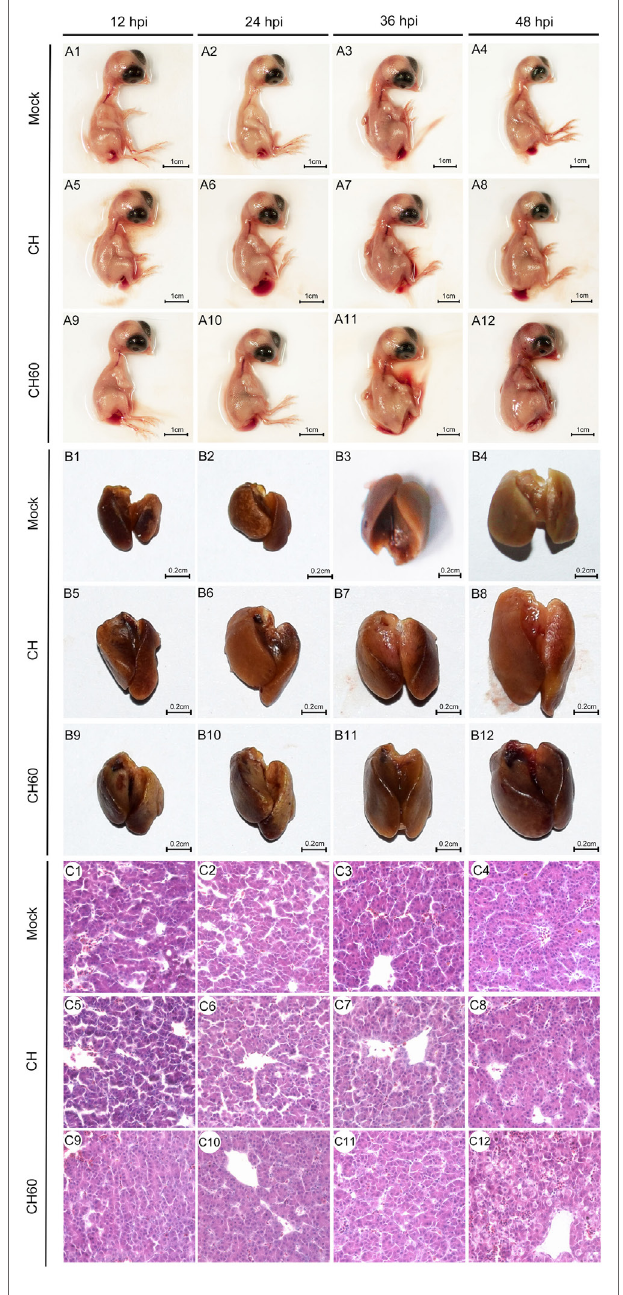
FigUre 1 | Gross lesions and histopathological lesions in CH- or CH60- infected livers of embryonated eggs. Embryonated eggs were infected with the CH or CH60 strain, and then the livers were collected and soaked in 4% paraformaldehyde solution at 12, 24, 36, and 48 hpi. Microscopic lesions were observed under an optical microscope; magnification, 600 ×